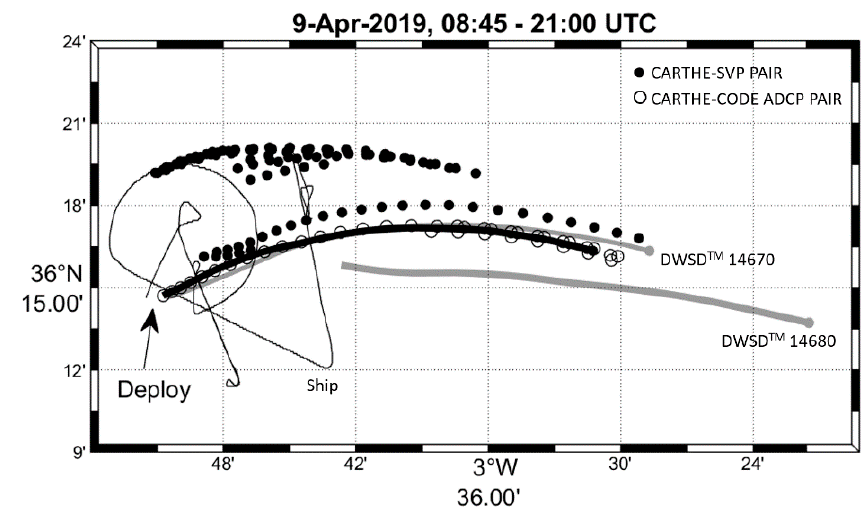
Figure 5. Trajectories of the CODE ADCP drifter (thick black) and positions of the CARTHE–SVP (black dots) and CARTHE–CODE ADCP (circles) pairs on 9 April 2019 between 8:45 and 20:47 UTC. Trajectories of the DWSD TM drifters (14670—thin gray, and 14680—thick gray) drifters and RV Pourquoi Pas? track (thin black) for the same period. All drifters are moving eastward.